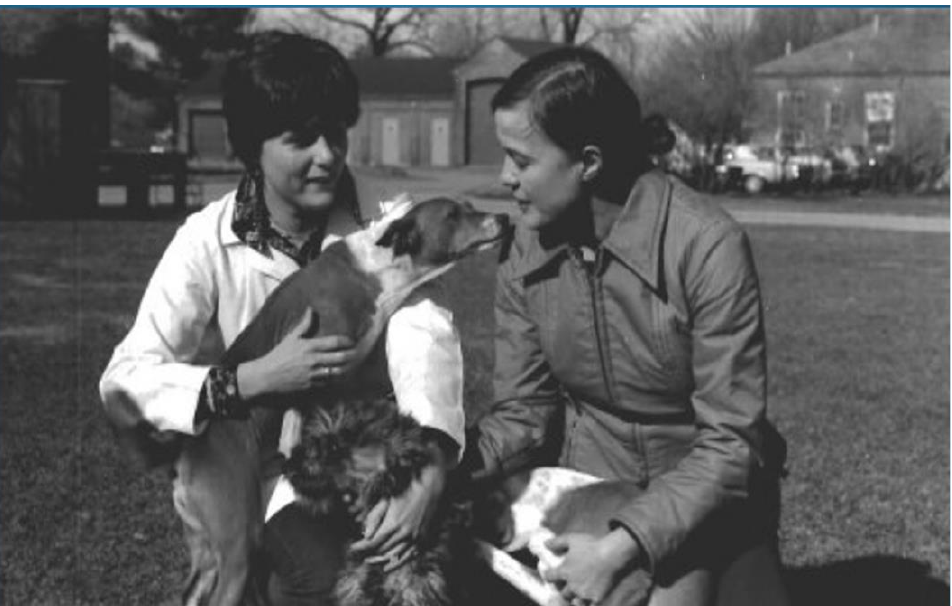
Figure 1. The Author and technician, the late Joanne Kull, with hemophilic dogs at Griffin Laboratory, New York State Department of Health, 1975 [39].